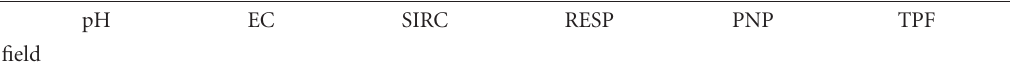
Table 2: Pearson correlation ( r ) matrix correlating chemical and biological soil parameters on a subfield and full field basis (whole field n = 220, subfield n = 50 to 55). Values in red are significant correlations where . 01 < P < . 05% probability